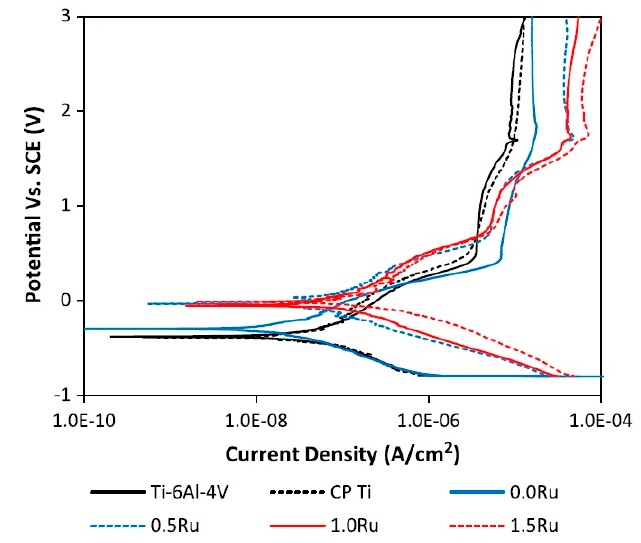
Figure 7. Representative potentiodynamic polarization curves of titanium alloys in Hank’s balanced salt solution (HBSS) [69].